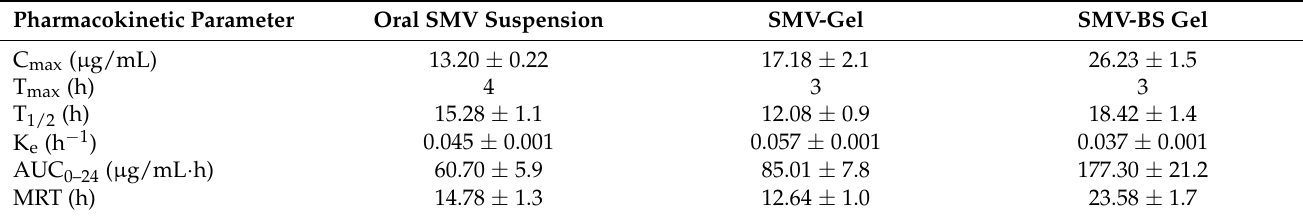
Table 4. Pharmacokinetic parameters of various SMV